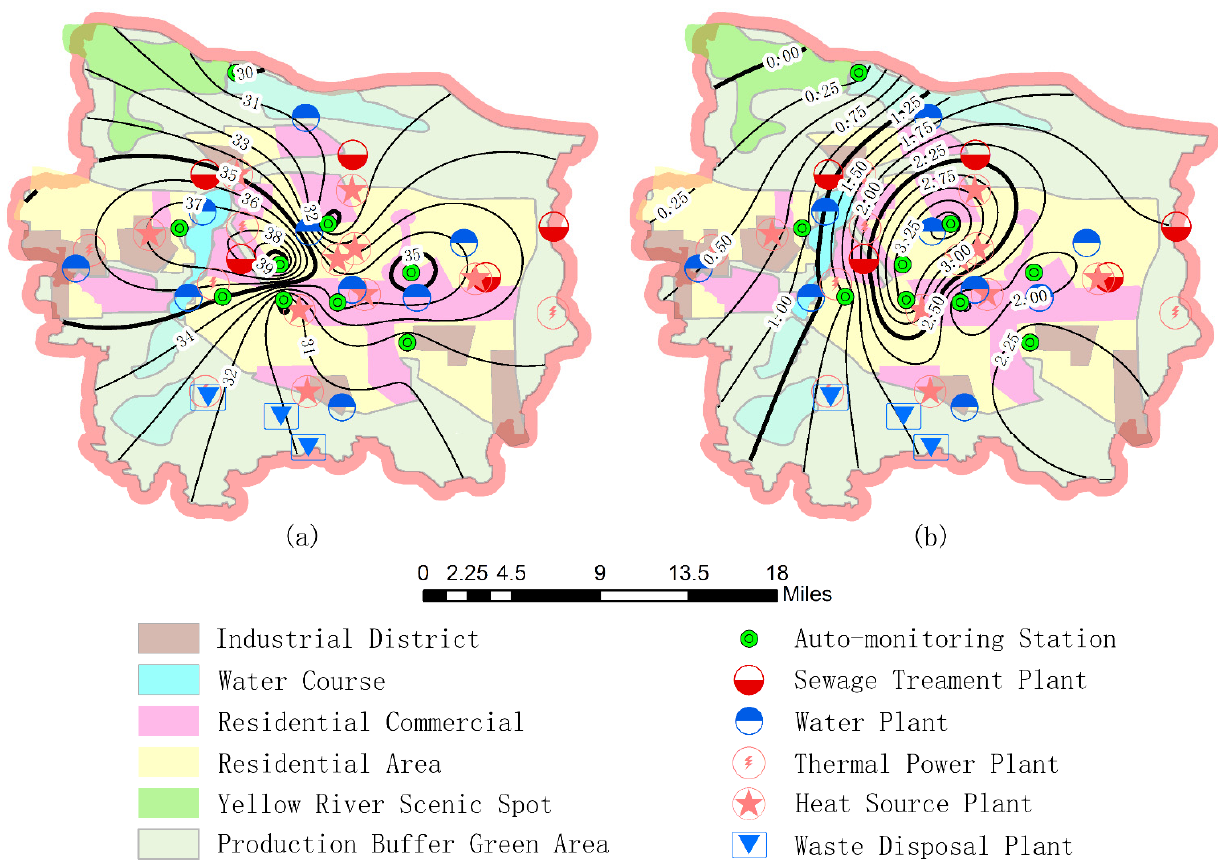
2 value (0 ≤ q ≤ 20 ) χ value ( 0 20 q ≤ ≤ ). Figure 7. The spatial distribution of ( a ) SO 2 concentration and ( b ) χ shuf f shuff